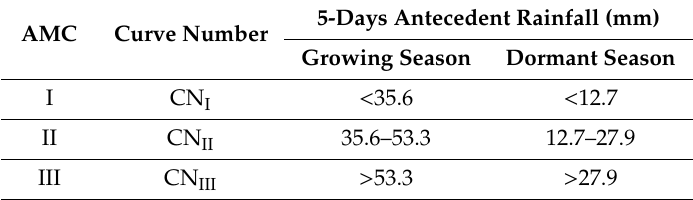
Table 2. Classification of the antecedent soil moisture condition and the related curve number